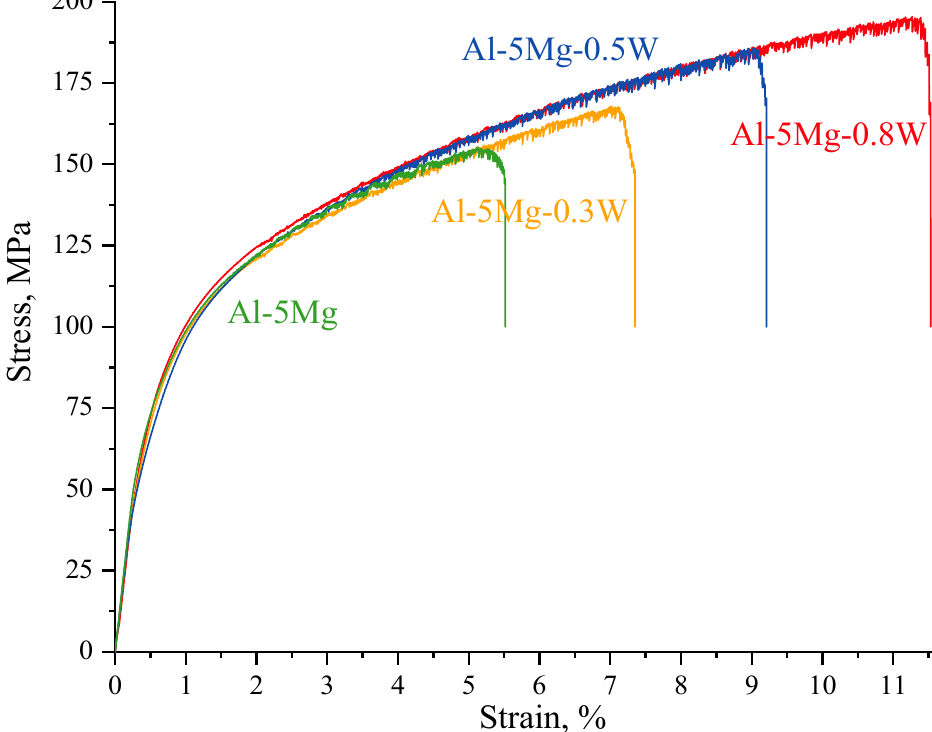
Figure 6. The stress–strain curves for the Al-5Mg and Al-5Mg-W alloys. Introducing 0.3 wt.% of W nanoparticles results in an increase in the hardness from 57 to 64 HB, microhardness from 68 to 71 HV, yield strength from 80 to 85 MPa, and ductility from 5.2 to 6.4%. There is also a slight increase in the ultimate tensile strength from 155 to 164 MPa. The introduction of 0.5 wt.% W nanoparticles led to an increase in hardness from 64 to 69 HB, ultimate tensile strength from 164 to 185 MPa, and ductility from 6.4 to 8.5%. At the same time, there is no increase in microhardness and